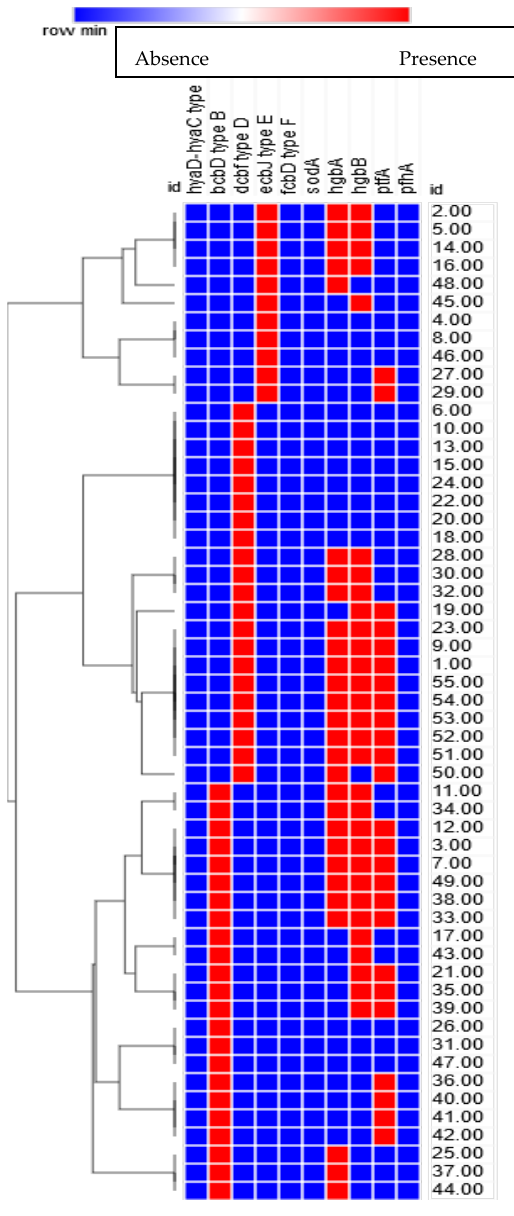
Figure 3. Heatmap and hierarchical clustering of the P. multocida isolates to 17 clusters based on the molecular detection of capsular types and virulence genes. The numbers on the right of the heatmap refer to the isolate numbers from 1 to 55.